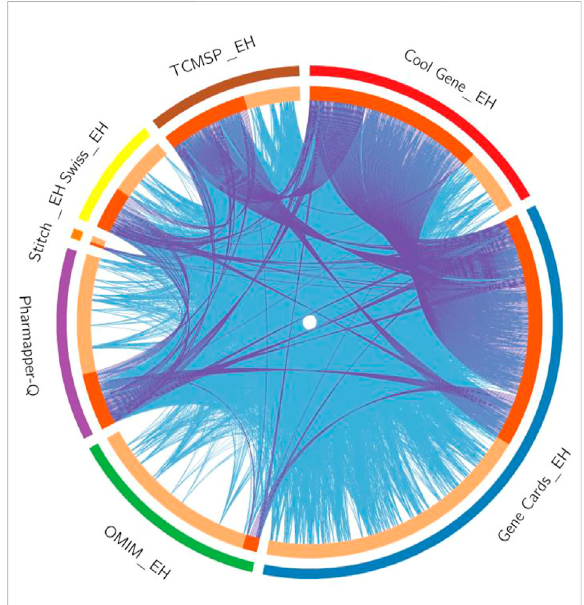
FIGURE 1 The Circos plot shows intersecting genes. The outer arcs symbolize the identity of each gene. Each of the inside arcs representsagene,andeachgeneisrepresentedbyitsownspoton the arc. The dark orange color indicates genes found in multiple databases, whereas the light orange color signi fi es genes found only in that gene datasets. Purple lines connect identical gene that seems in speci fi c genes databases. Blue lines connect the genes that identi fi ed as similar